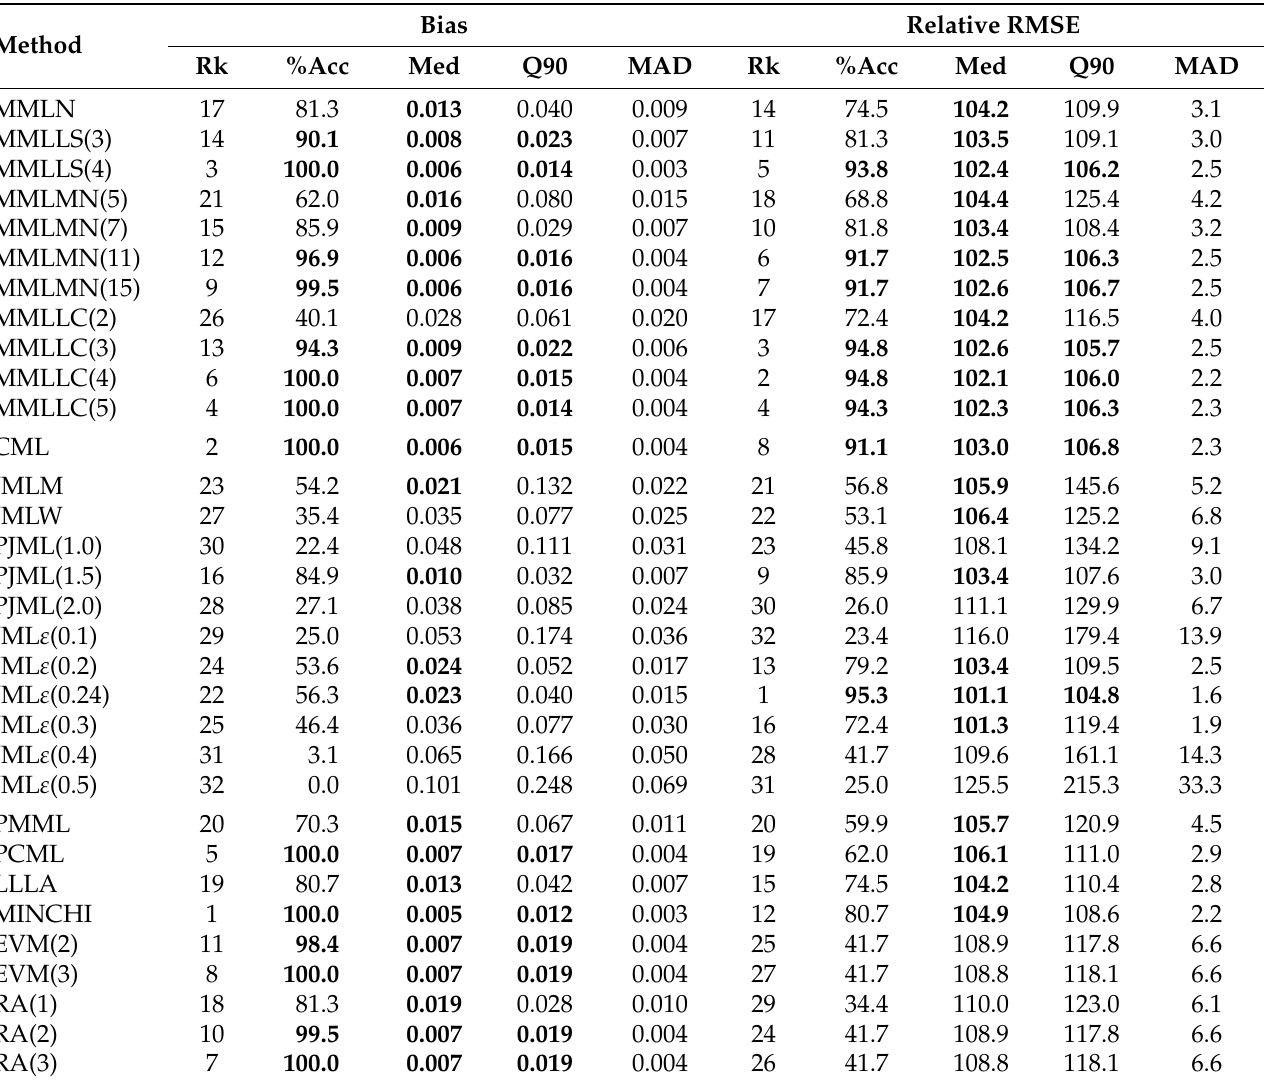
Table 2. Summary of results for (mean absolute) bias and relative RMSE for different estimation methods across all simulation